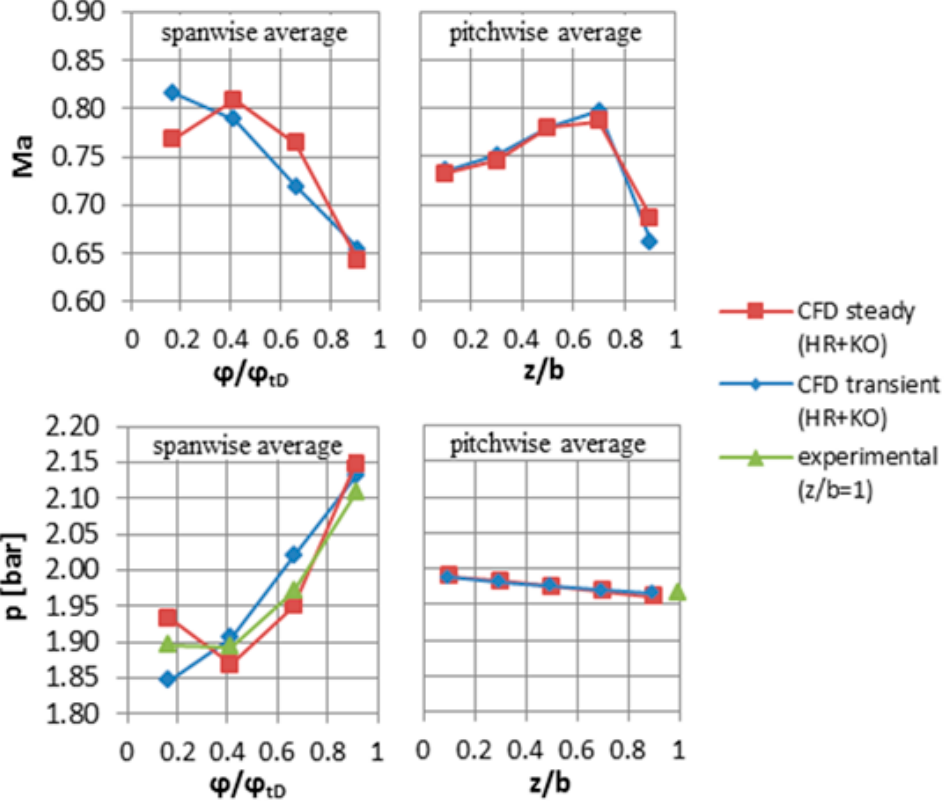
Figure 8. Mach number and pressure at 2M and P1 point.